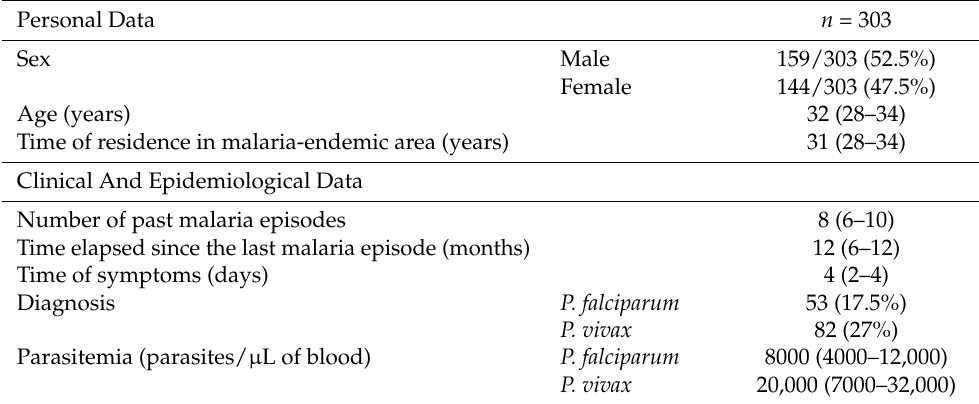
Table 1. The studied population’s personal, clinical, and epidemiological